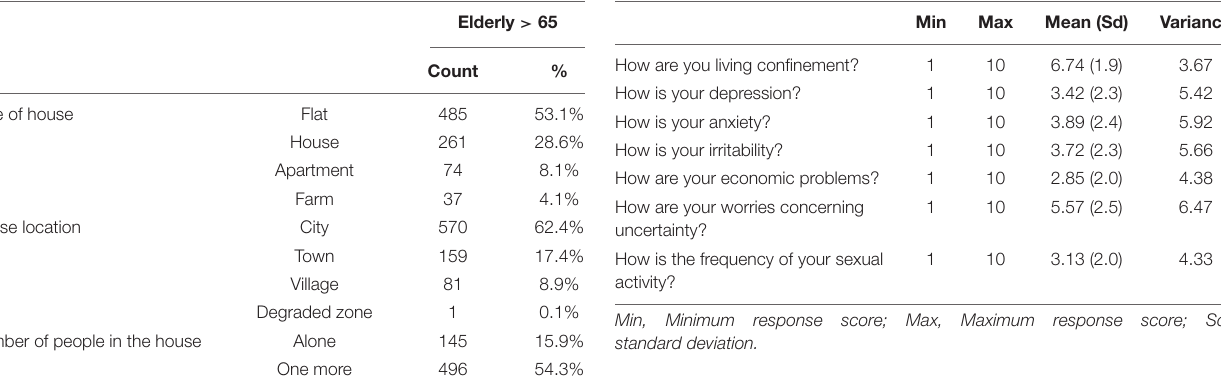
TABLE 2 | Housing characteristics of the elderly during Lockdown period. TABLE 3 | Psychosocial factors of the